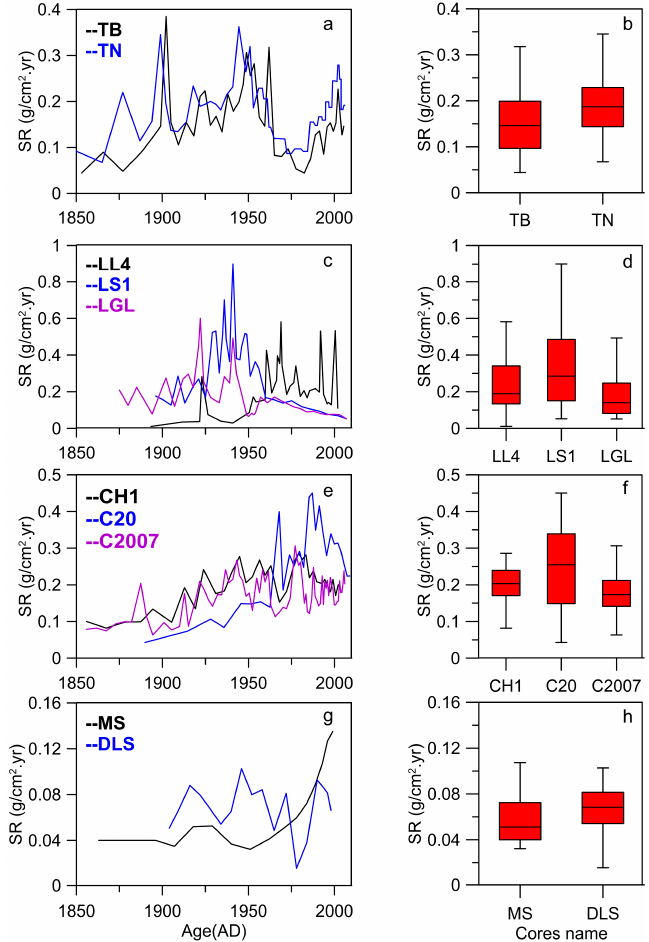
Figure 3. SRs of different cores within the same lake for Taibai, Longgan, Chaohu and Taihu Lake: ( a – g ) SR variations with time; and ( b – h ) corresponding boxplots with all data (Data of LGL core and LS1 core in Longgan Lake, and data of DLS core in Taihu Lake modified from [49,50], respectively).